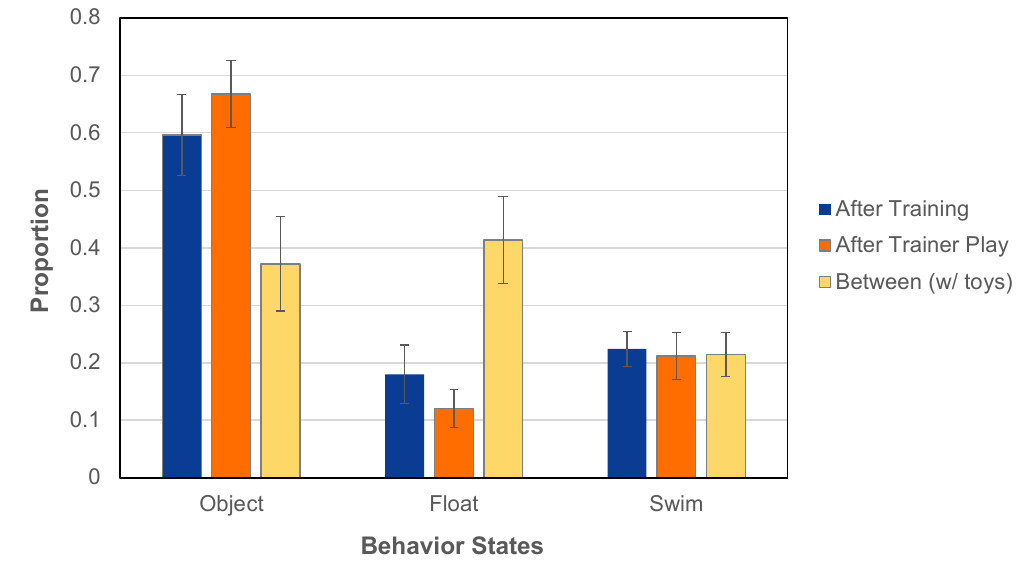
Figure 4. Mean proportion of intervals (+/ − SEM) spent in each behavioral category during each condition, Phase 2.